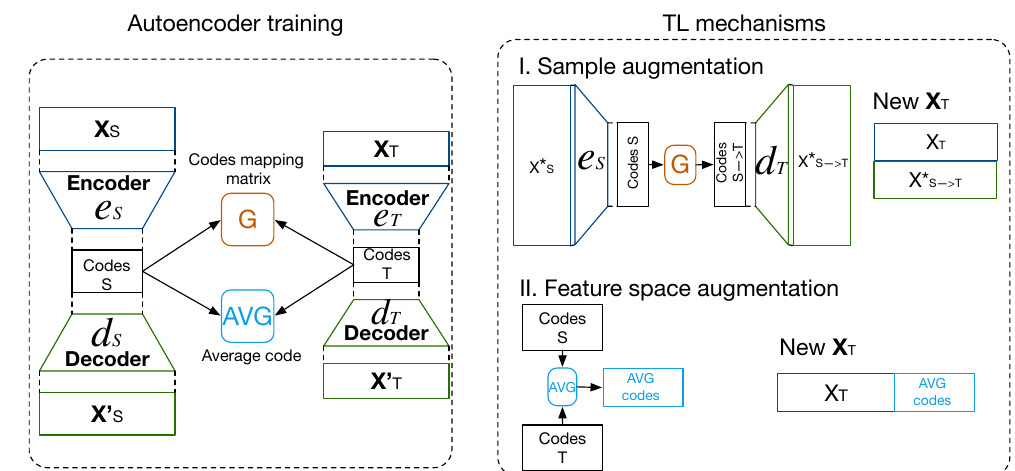
Figure 4. Scheme of proposed method for transfer of samples between domains and feature space augmentation to support learning tasks in the target domain. In the training stage, codes are extracted, and G and average codes (AVG codes) are computed as TL bridges between both